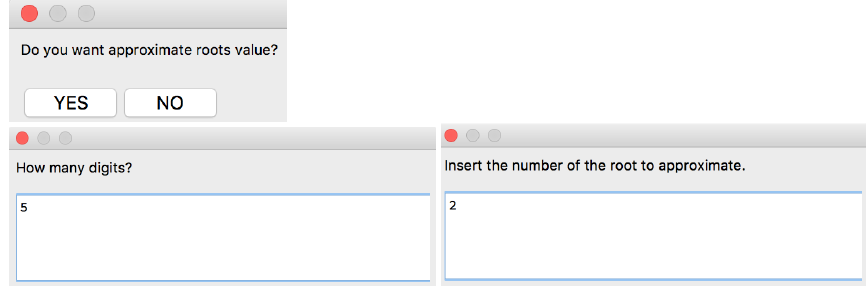
Figure 34. Part of the structure of the [ARoots] algorithm corresponding to the option to get an approximate root